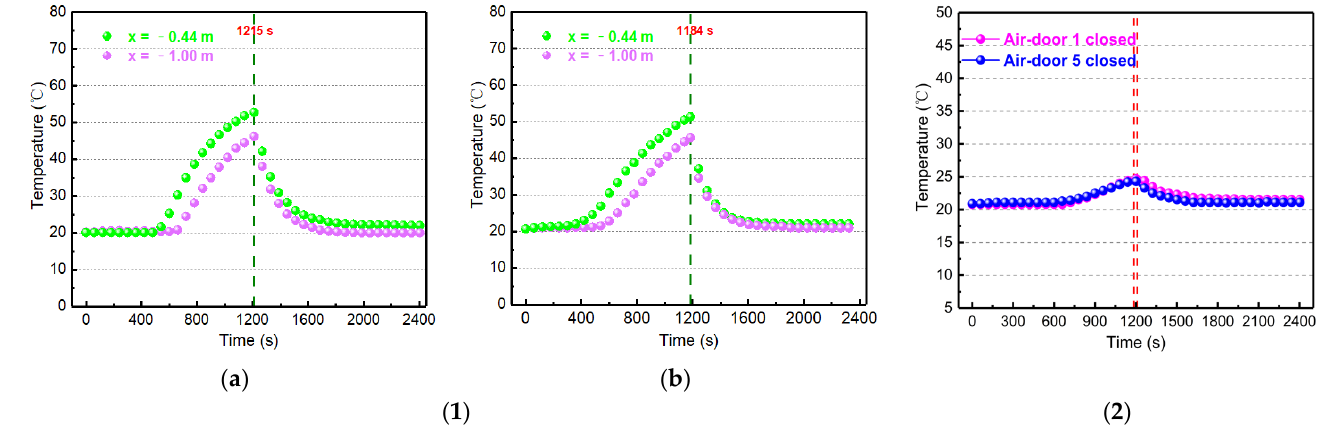
Figure 8. Temperature variation for different schemes when the ventilation velocity is 1.70 m/s: ( 1 ) Temperature variation at different locations upstream of the fire source: ( a ) Air-door 1 closed. ( b ) Air-door 5 closed. ( 2 ) Temperature variation in the diagonal branch.